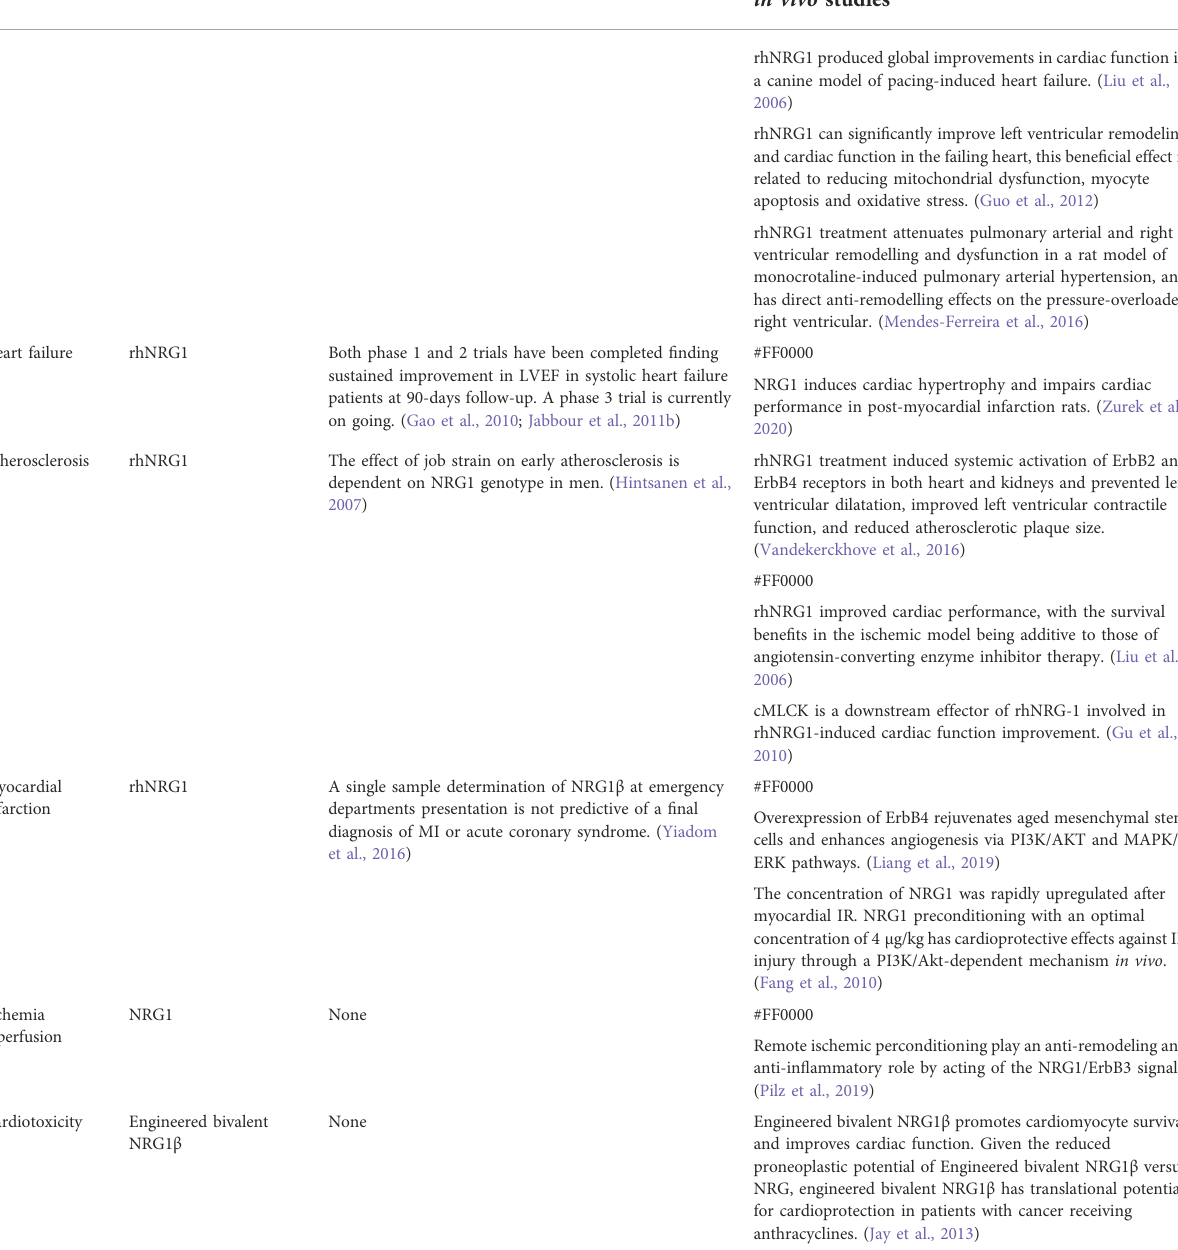
TABLE 1 The role of NRG1 in cardiovascular disease.